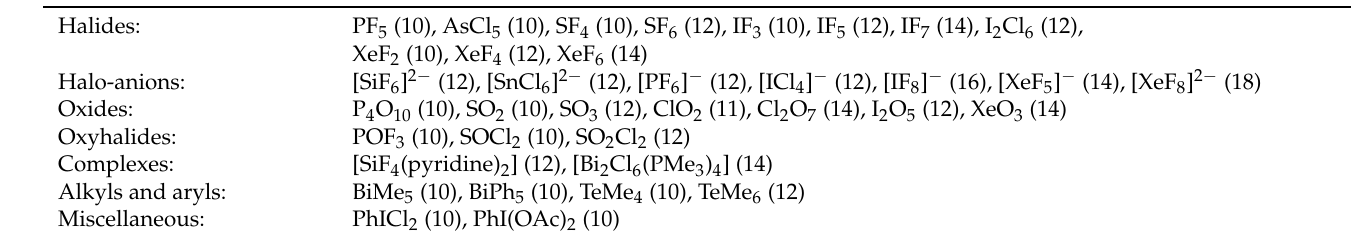
Table 1. A selection of examples of compounds of the 3p, 4p, 5p, and 6p elements generally classified as hypervalent a